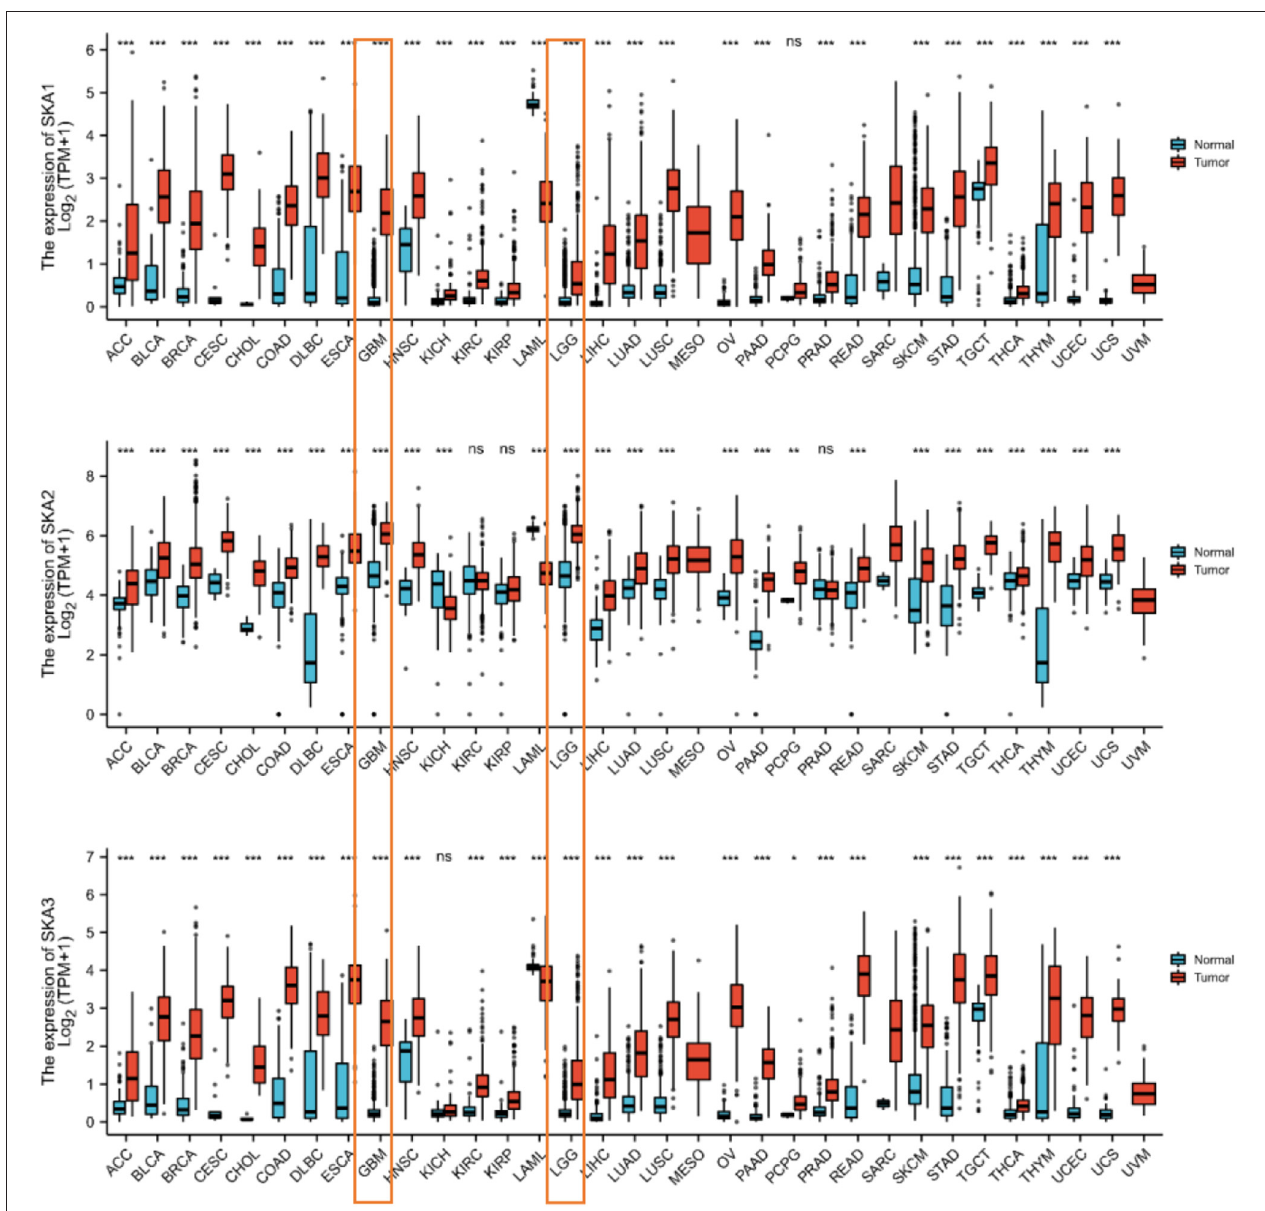
FIGURE 1 | The expression of the SKA complex (SKA1, SKA2, and SKA3) genes in the tumor tissues and non-paired normal tissue in 33 human cancers. The expressions of LGG and GBM are boxed. * p < 0.05; ** p < 0.01; *** p < 0.001; ns, not significant.